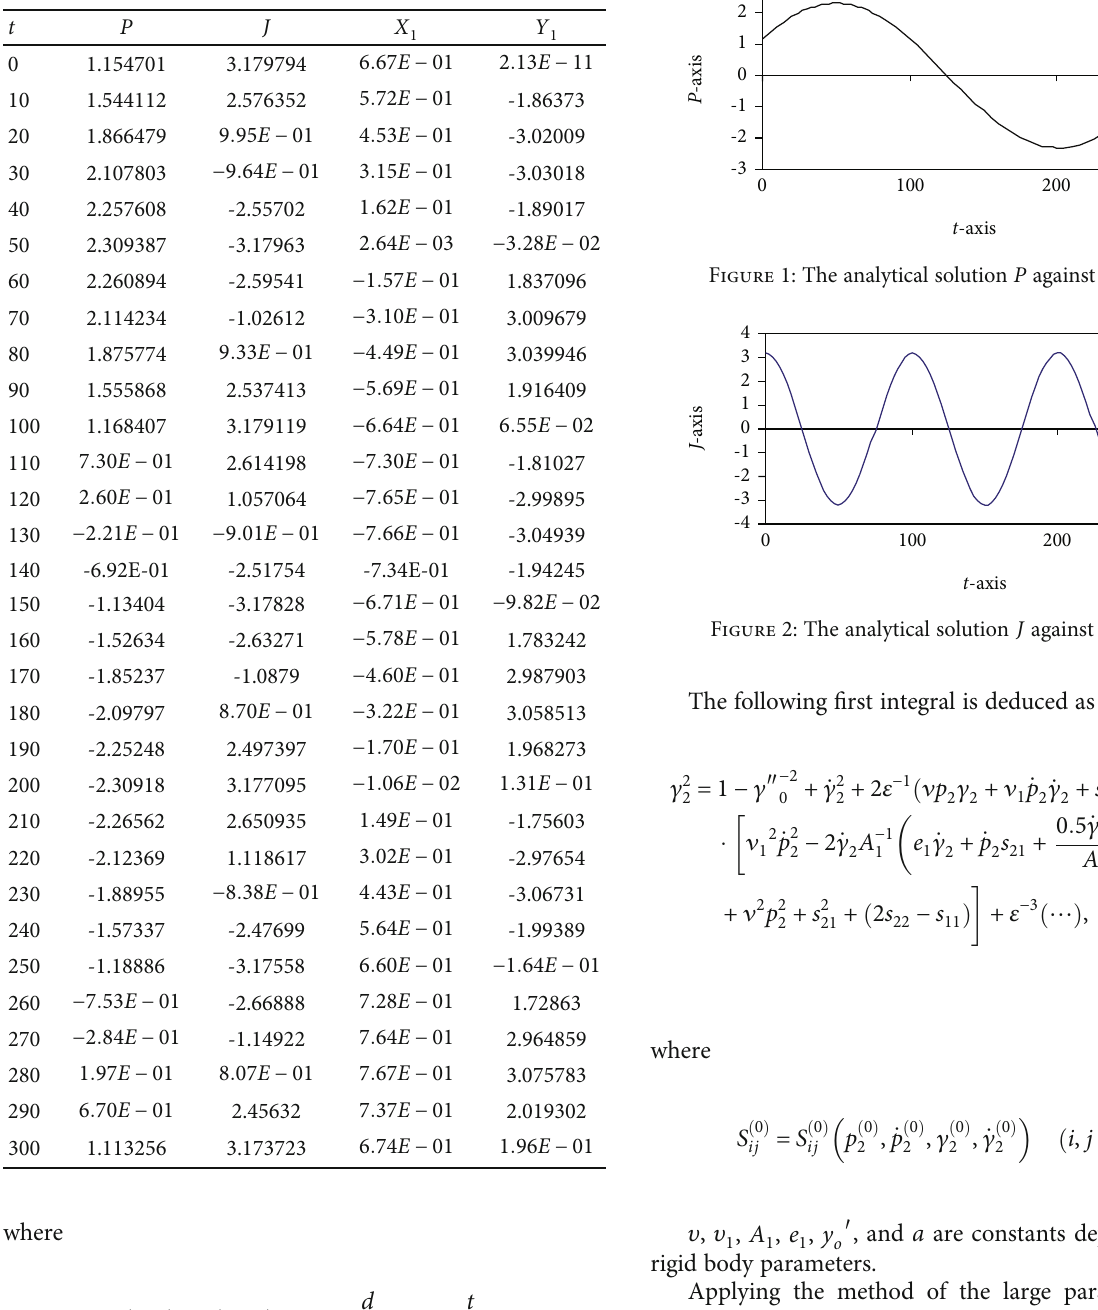
Table 1: The analytical solutions when ω = 1/3 .